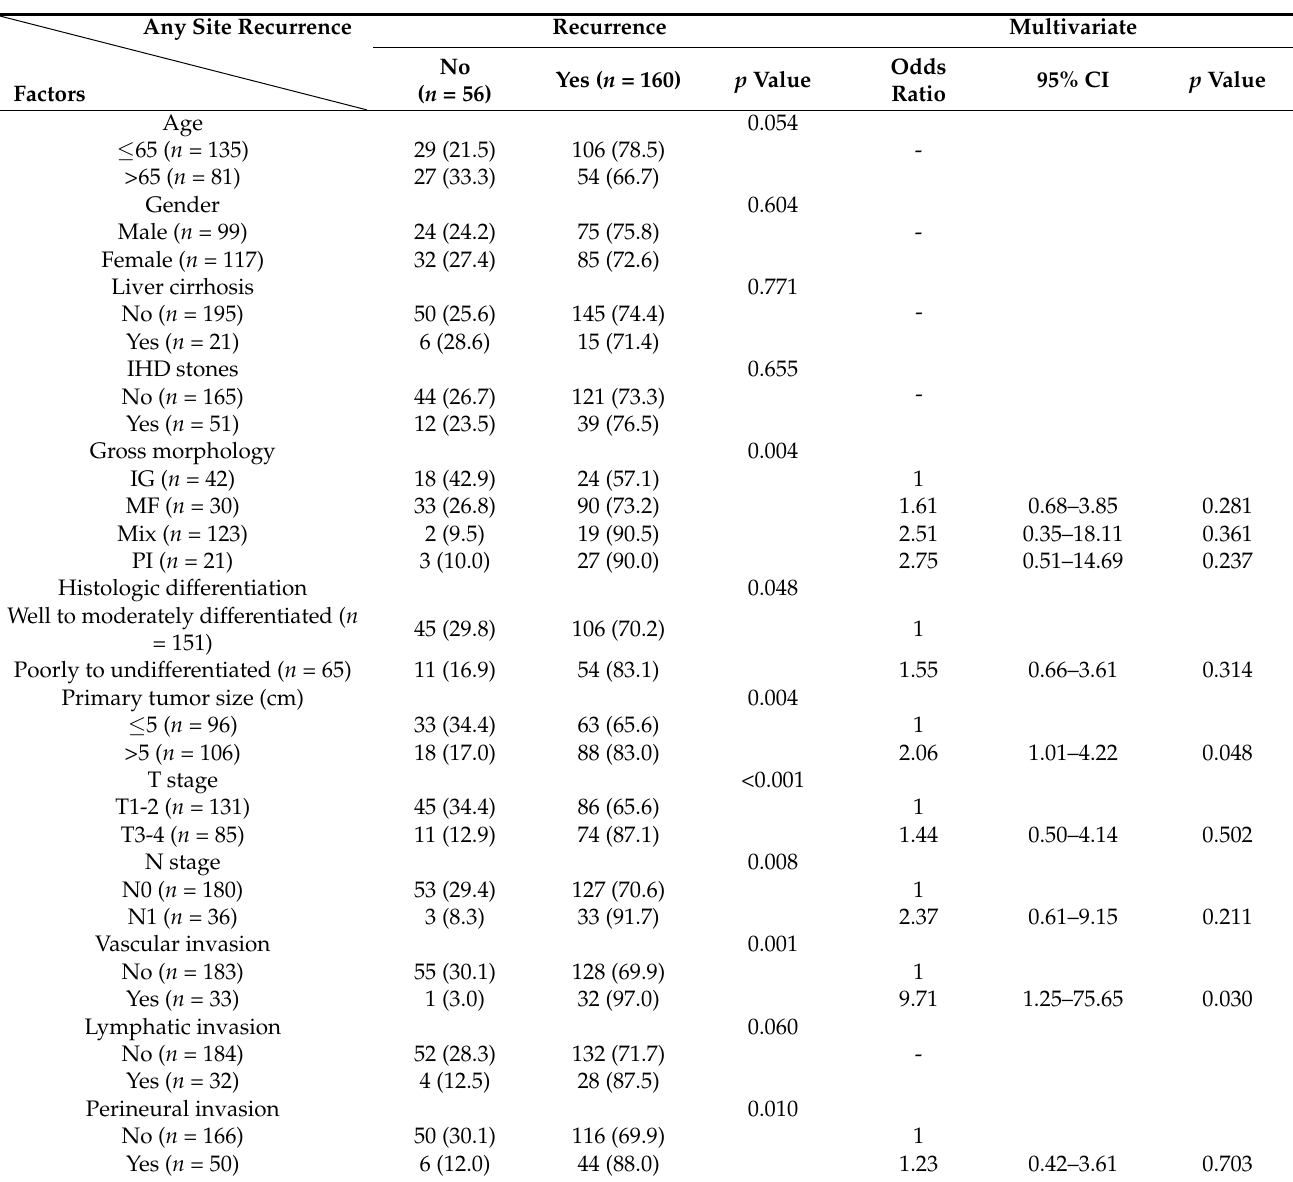
Table 2. Univariate and multivariate logistic regression model to predict risk factors for any site